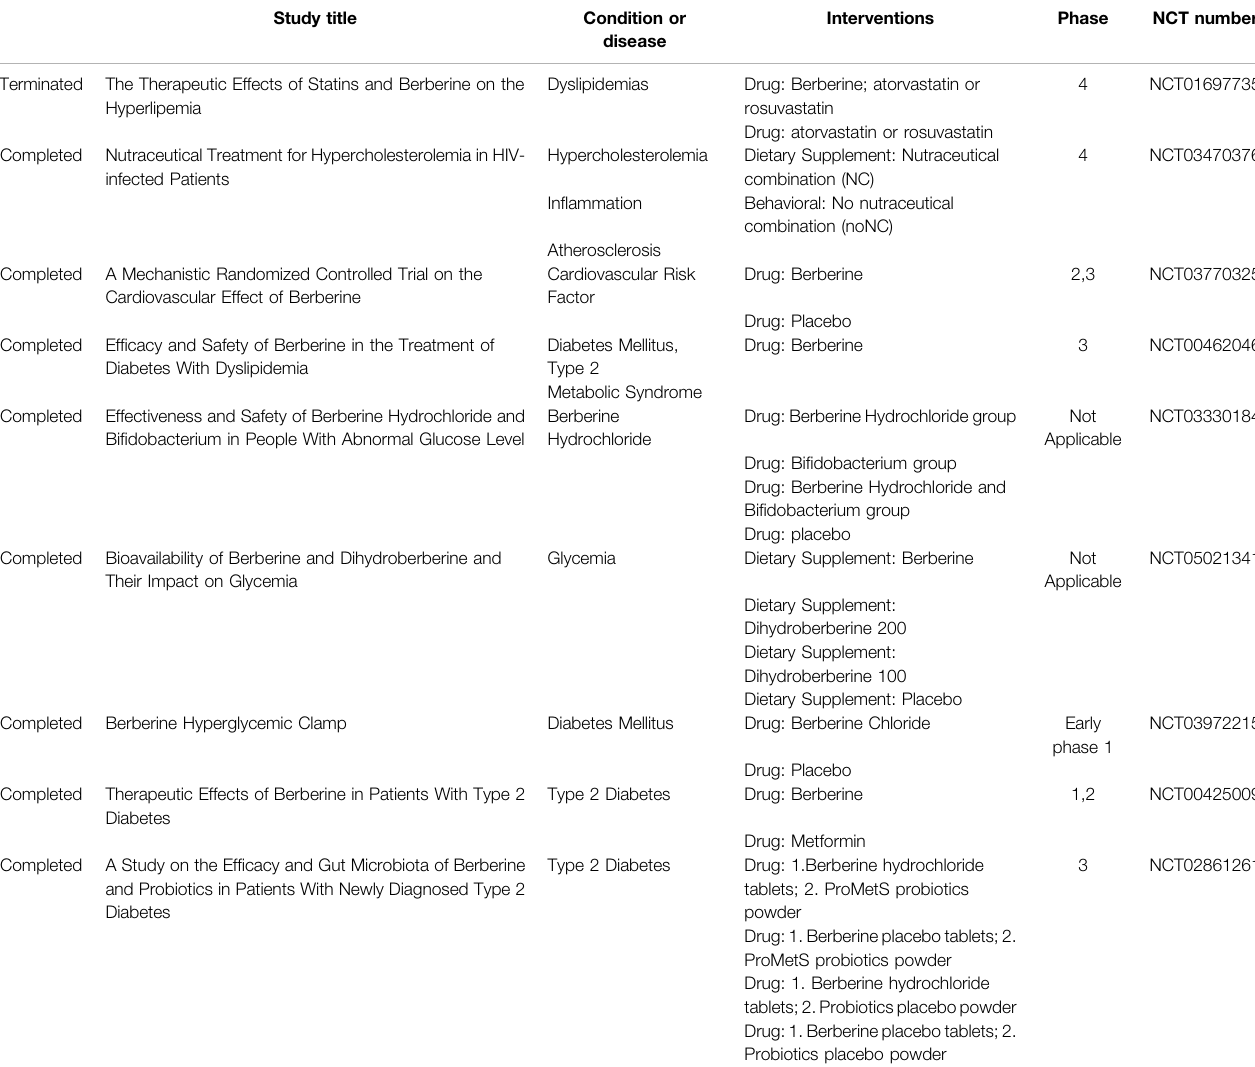
TABLE 3 | Berberine in clinical trials for metabolic